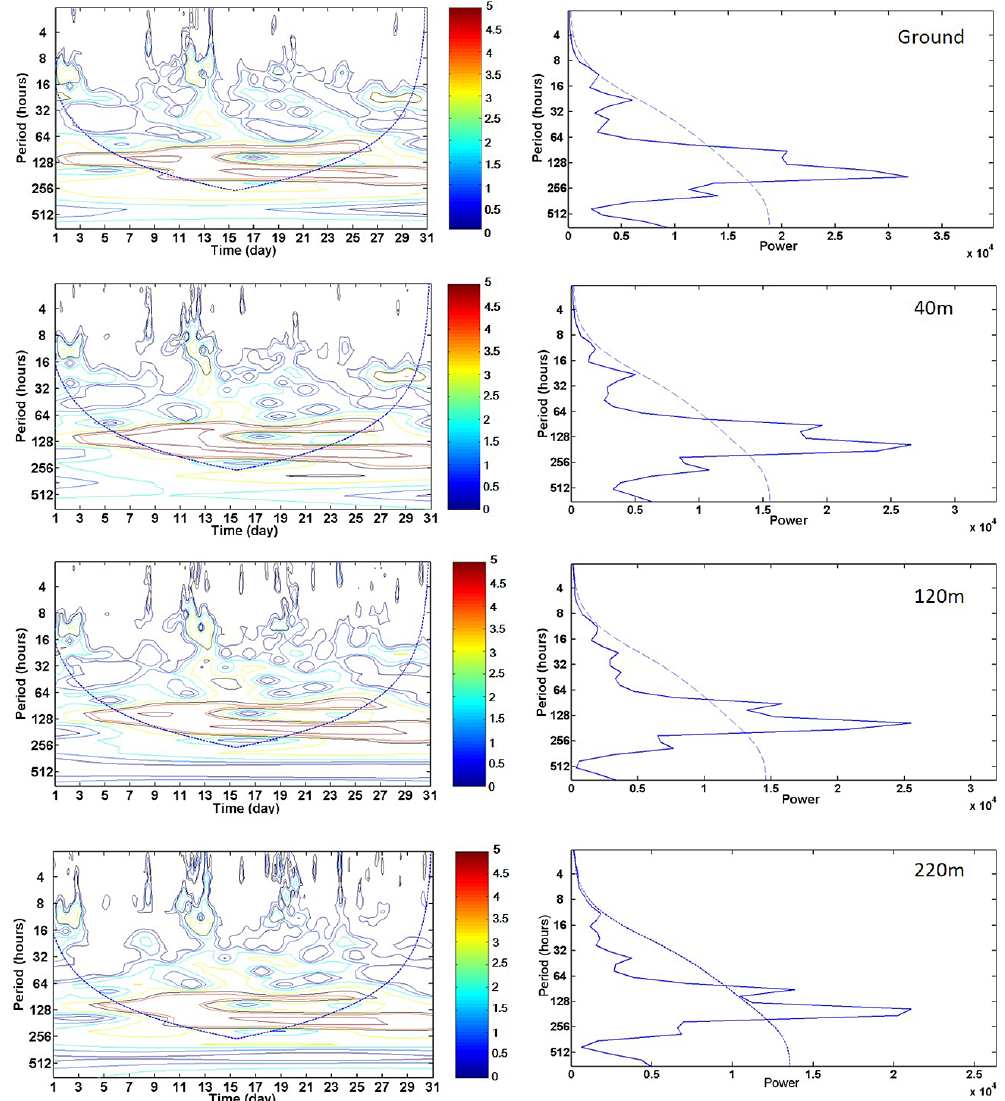
Figure 6. Local (left panels) and global (right panels) wavelet power spectrum of PM 2 . 5 mass concentration at different heights in Au- gust